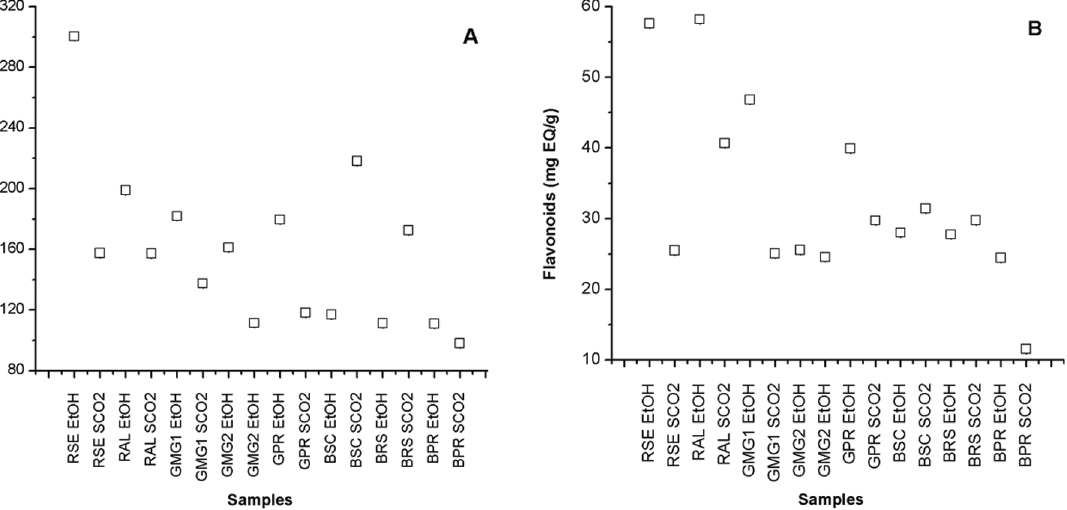
Fig 3. Content of total phenolic compounds expressed in mg EAG/g (A) and of flavonoids expressed in mg EQ/G (B) of the extracts of different samples of Brazilian propolis. SCO 2 – Extracts obtained by SFE; EtOH – Extracts obtained by ethanolic extraction; Lower values of IC 50 indicate a higher activity of radical elimination; Average of analysis obtained in triplicate (n =